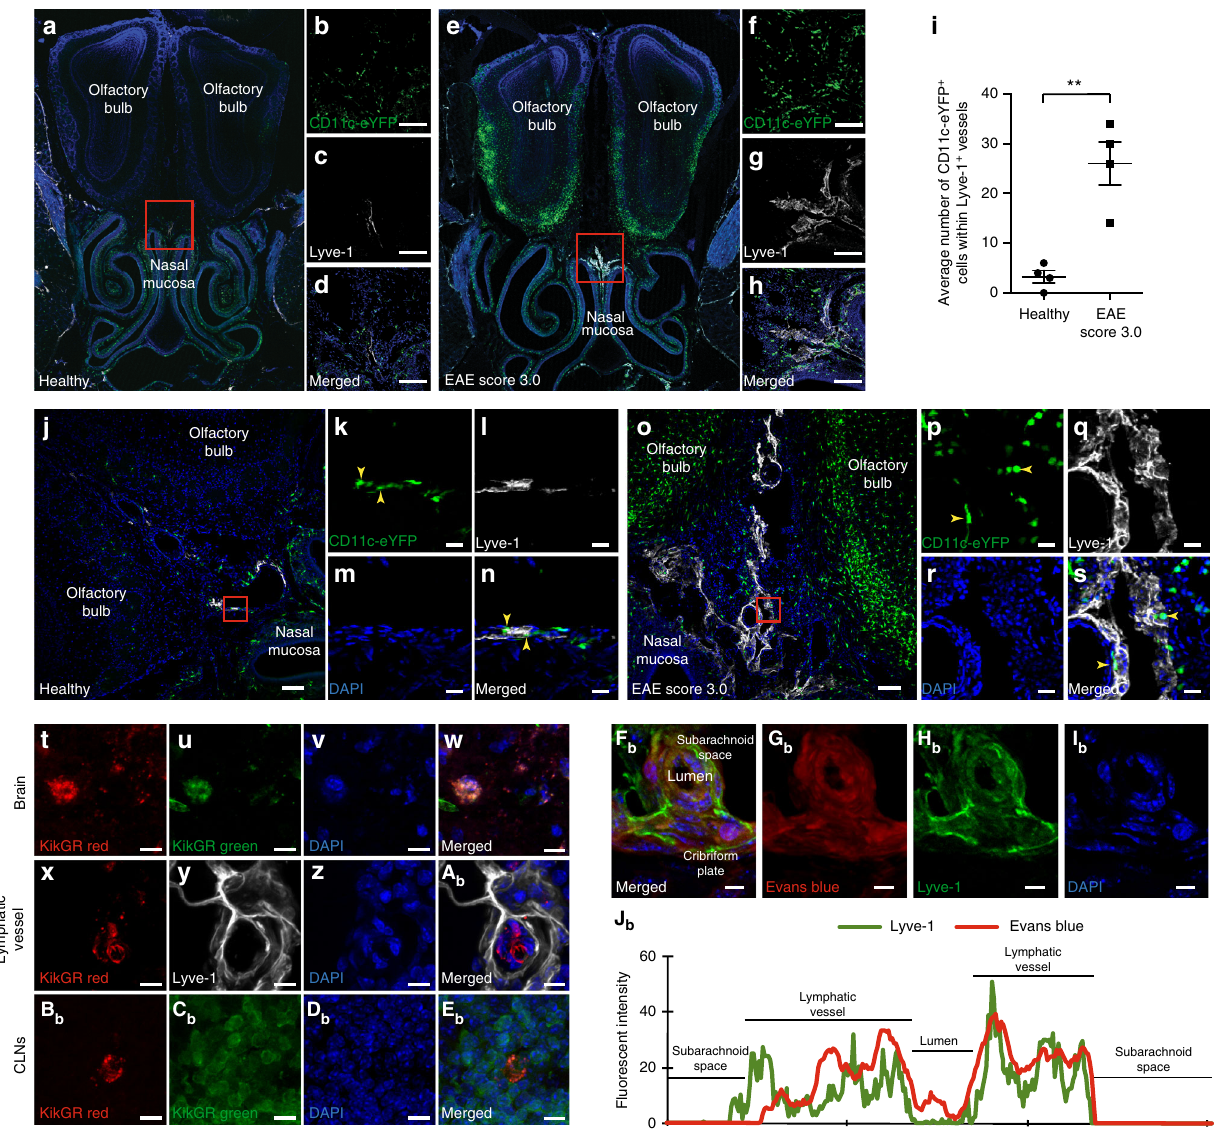
Fig. 3 Lymphangiogenic vessels can functionally carry cells and CSF during EAE. a – h Representative confocal images of the olfactory bulbs, cribriform plate, and nasal mucosa were imaged from a healthy ( a – d ) or EAE Score 3.0 ( e – h ) and immunolabeled with Lyve-1 and DAPI. b – d Magni fi ed image of the red inset shown in a . f – h Magni fi ed image of the red inset shown in e . Scale bars = 100 µ m. i Quantitation of CD11c-eYFP + cell number within Lyve-1 + vessels. Orthogonal views were used for quantitation to con fi rm that the CD11c-eYFP + cells quanti fi ed were within Lyve-1 + vessels ( n = 4 mice per group; data are represented as mean ± SEM, ** p < 0.01, unpaired Student ’ s t -test). j , s Higher magni fi cation images from either healthy ( j – n ) or EAE Score 3.0 ( o – s ) CD11c- eYFP transgenic reporter mice showing CD11c-eYFP + cells within Lyve-1 + vessels. k – n Magni fi ed image of the red inset in j . p , s Magni fi ed image of the red inset in o . Scale bars = 100 µ m for ( j, o ) and 20 µ m for ( k – n , p – s ). t – E b KikGR transgenic mice were induced with EAE, and at EAE score 3.0 were intracerebrally photoconverted to visualize if photoconverted cells originating from the CNS parenchyma can be found within lymphangiogenic vessels near the cribriform plate and the draining lymph nodes. Representative images show green-red photoconverted cells at the site of photoconversion within the brain ( t – w ), within lymphatic vessels near the cribriform plate ( x – A b ), and within the cervical lymph nodes (CLNs) ( B b – E b ). F b – I b ): Wild-type animals were induced with EAE, and at peak EAE 10 µ l of 10% Evans blue dye was injected into the cisterna magna at a rate of 2 µ l/min to visualize the drainage of CSF within cribriform plate lymphatics. Representative images show co-localization ( F b ) of Evans blue dye ( G b ) within Lyve-1 + vessels ( H b ) and DAPI ( I b ). Scale bars = 10 µ m. J b Representative intensity pro fi le plot for Evans blue dye and Lyve-1 taken from a cross section of the image shown in F b showing co- localization of Evans blue dye within Lyve-1 + lymphatic endothelial